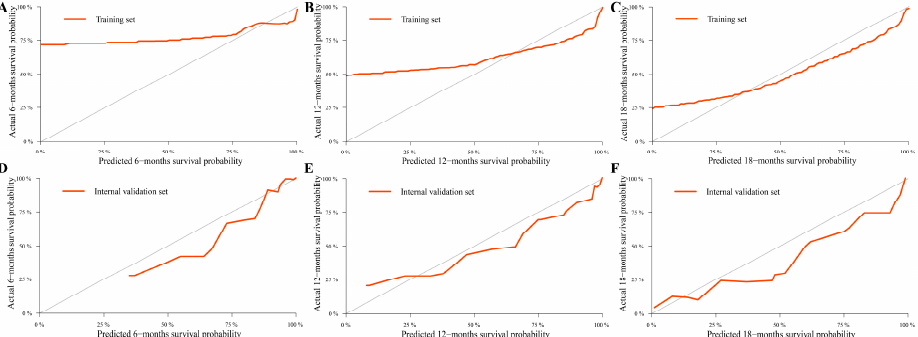
Figure 5. Calibration plots for predicting cancer-specific survival (CSS). Calibration curves for pre-